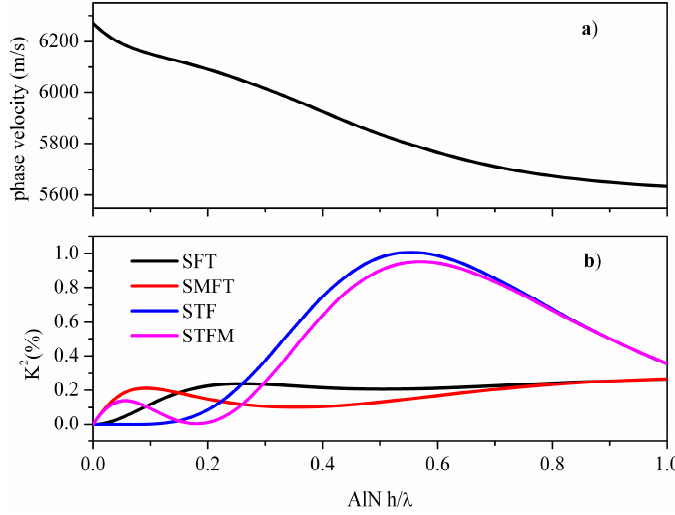
Figure 15. The phase velocity ( a ) and K 2 ( b ) dispersion curves for SAW propagating along 30° off the